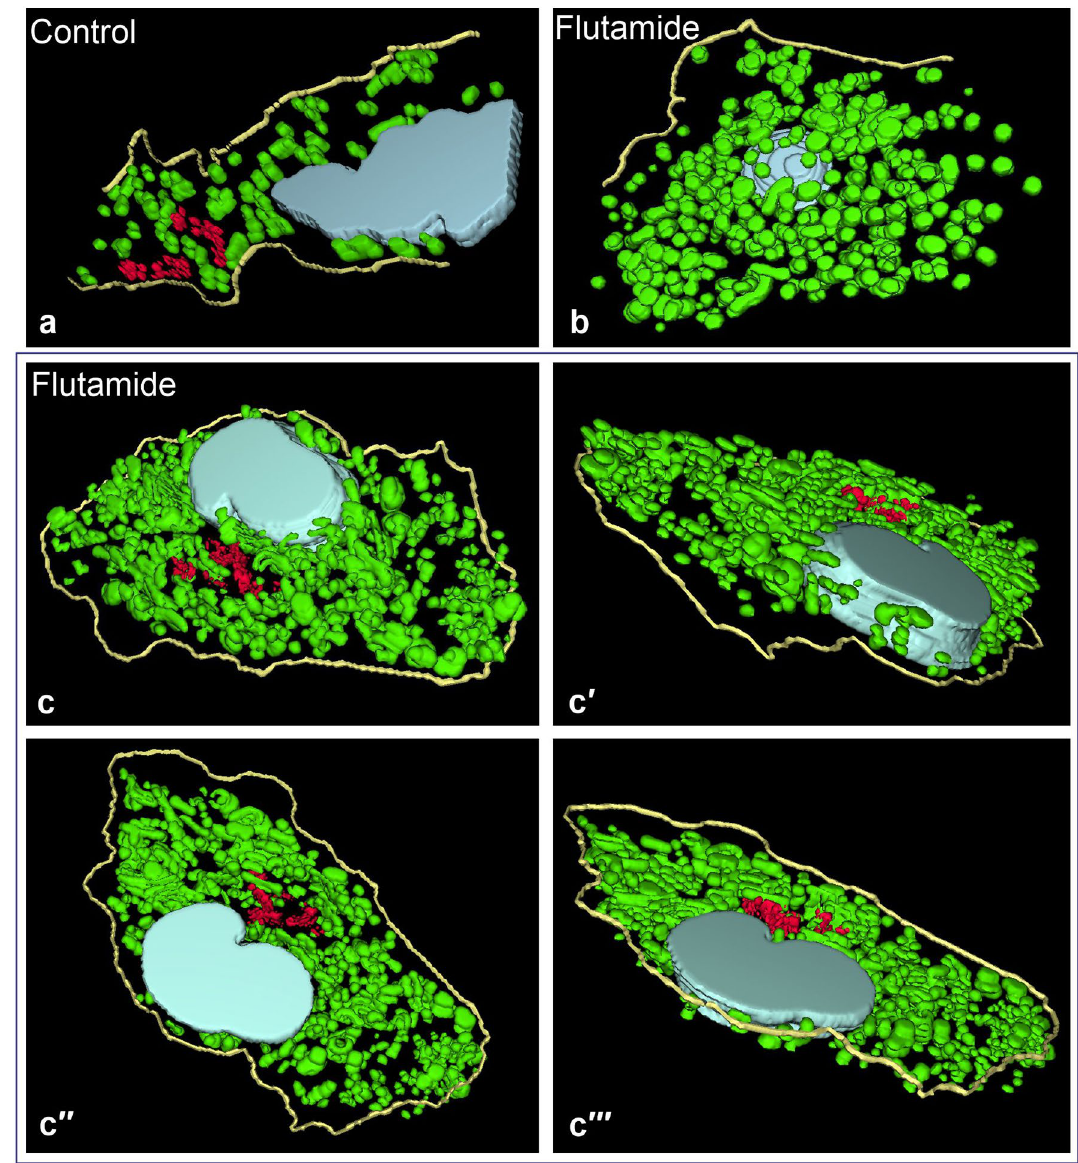
Figure 4. Computer aided 3D reconstructions of Leydig cells. ( a ) A sample 3D reconstruction of a “control” Leydig cell. ( b , c ) Sample 3D reconstructions of Leydig cells treated with flutamide. ( b ) A slightly altered cell. ( c - c ‴ ) A highly altered cell as seen from 4 different angles. Note mitochondria/mitochondrial networks (green), Golgi complexes (red), cell nuclei (light blue) and the cell outline (yellow). Three-dimensional reconstructions images were performed with the ImageJ Software (version 1.51 h), https:// imagej. nih. gov/